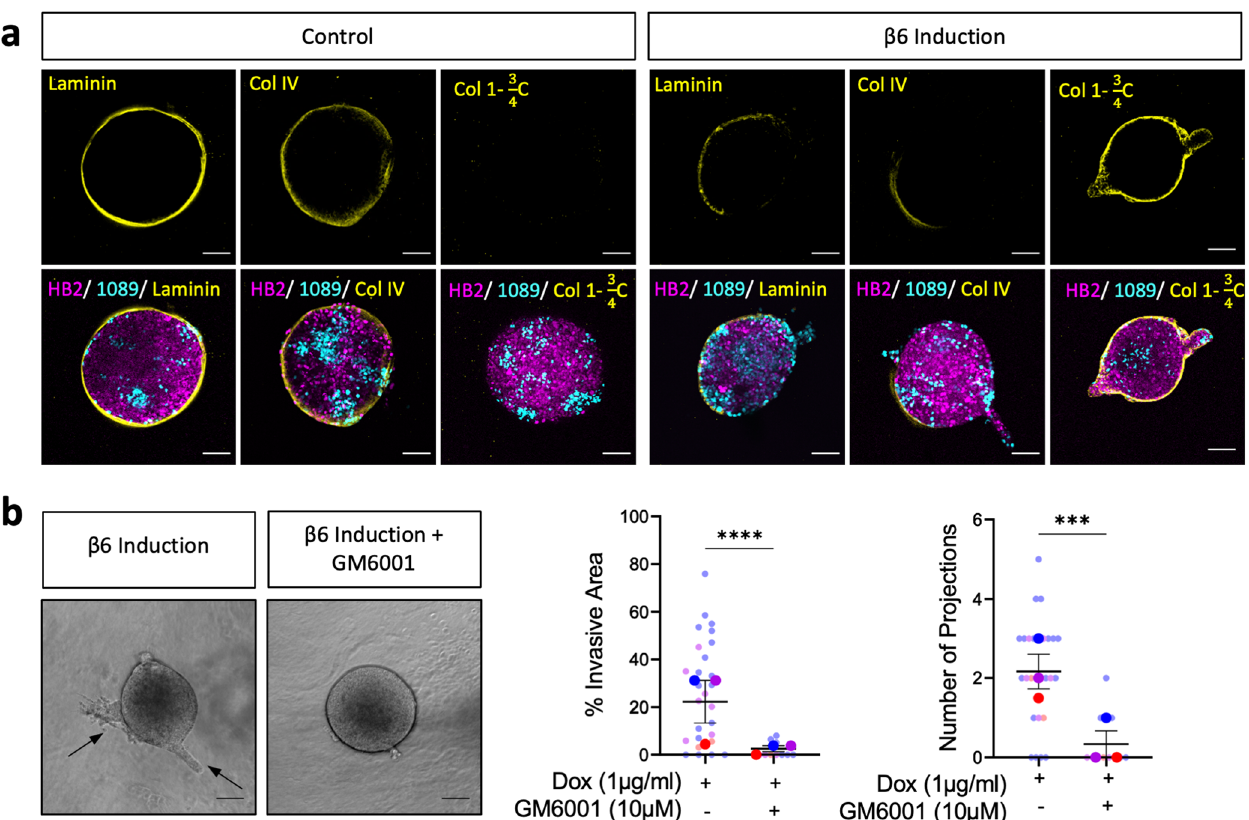
Fig. 2 β 6 driven myoepithelial-led invasion requires protease dependent cleavage of basement membrane proteins. a Representative fl uorescence confocal sections of HB2/1089 i β 6 spheres with HB2 (magenta), 1089 i β 6 (cyan), and Laminin, Collagen IV or Cleaved Collagen I (yellow) in control and β 6-induced conditions. b Representative bright fi eld images of HB2/1089 i β 6 spheres treated with doxycycline (1 µg/mL) and GM6001 (10 µM) at day 4 post treatment. Summary graphs showing percentage invasive area and number of projections. Data are presented as mean ± SEM where each dot represents one sphere with biological replicates indicated by different colours. Average of biological replicates indicated as larger-sized points. Data are representative of three independent experiments. *** p < 0.001, **** p < 0.0001 (Mann – Whitney U Test). Scale bar = 100